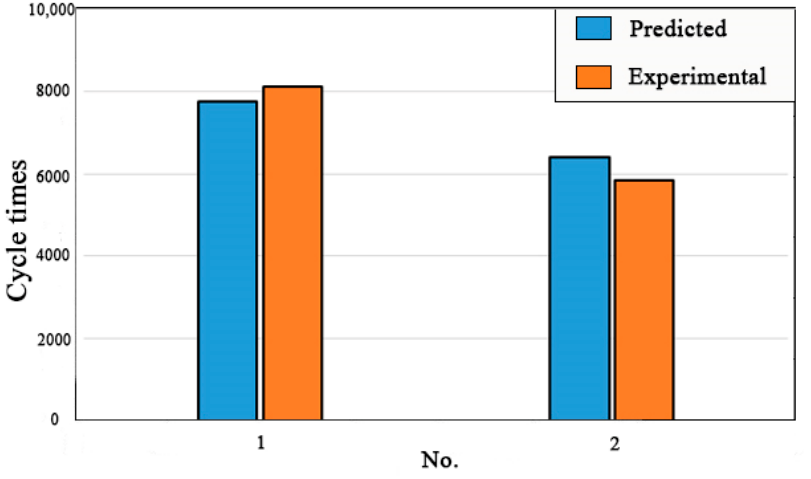
Figure 9. Damage cloud chart of specimen No. 2.